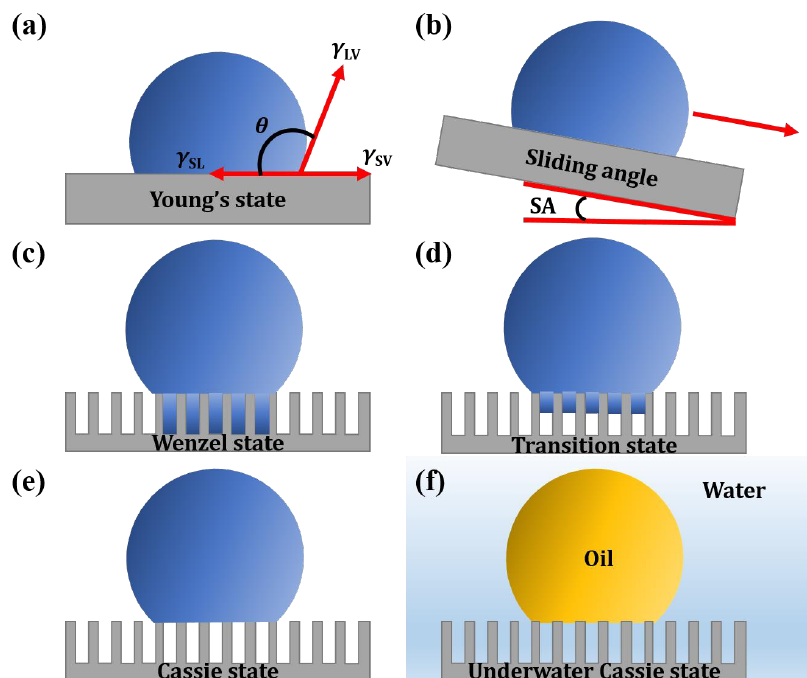
Figure 6. Di ff erent wetting states of water and oil droplets. ( a ) Young state of a droplet on a flat surface; ( b ) definition of the sliding angle (SA) or roll-o ff angle; ( c ) Wenzel state where the liquid completely wets the surface structures; ( d ) transitional or partial wetting state; ( e ) Cassie–Baxter state, where the droplet sits on the microstructures and air is trapped beneath it; and ( f ) oil droplet underwater in the Cassie–Baxter